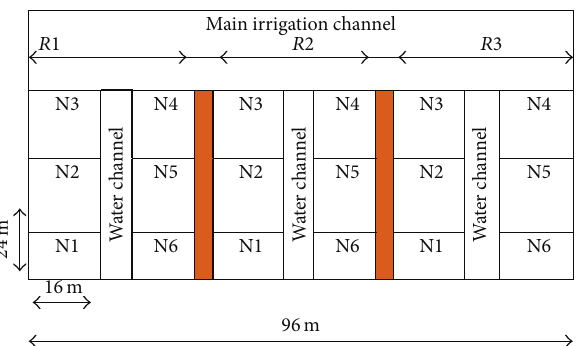
Figure 1: Field layout of the